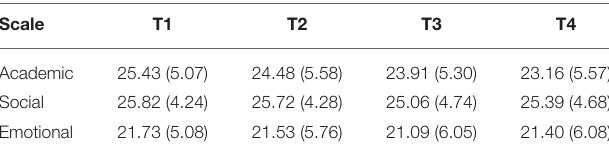
TABLE 4 | Mean and standard deviation statistics for self-efficacy at all-time